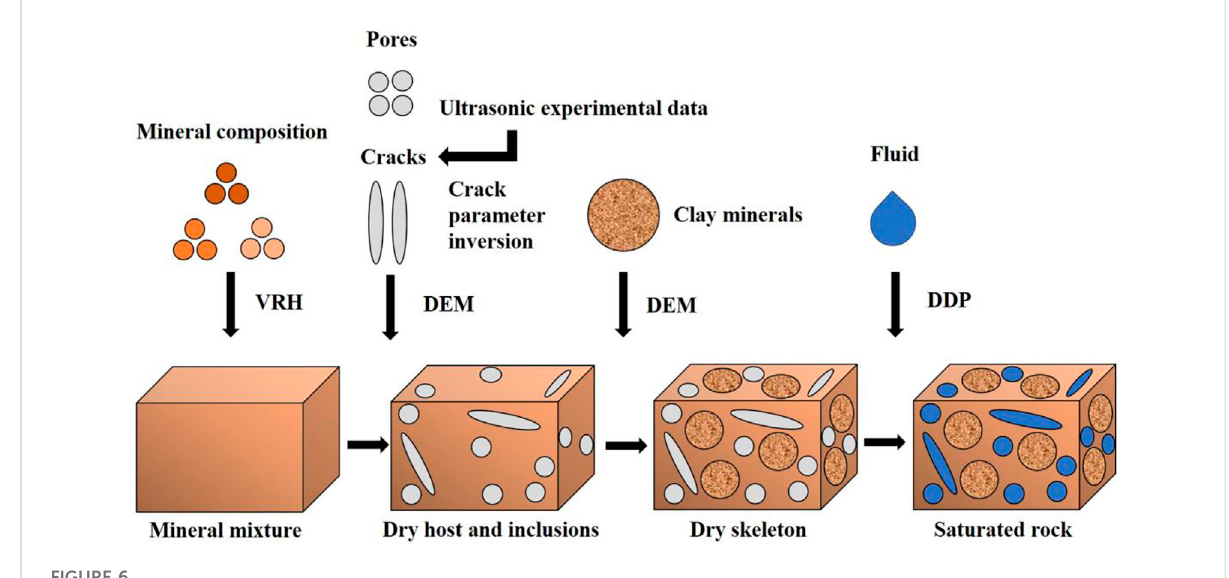
FIGURE 6 Modeling work fl ow to obtain wave velocity and attenuation.